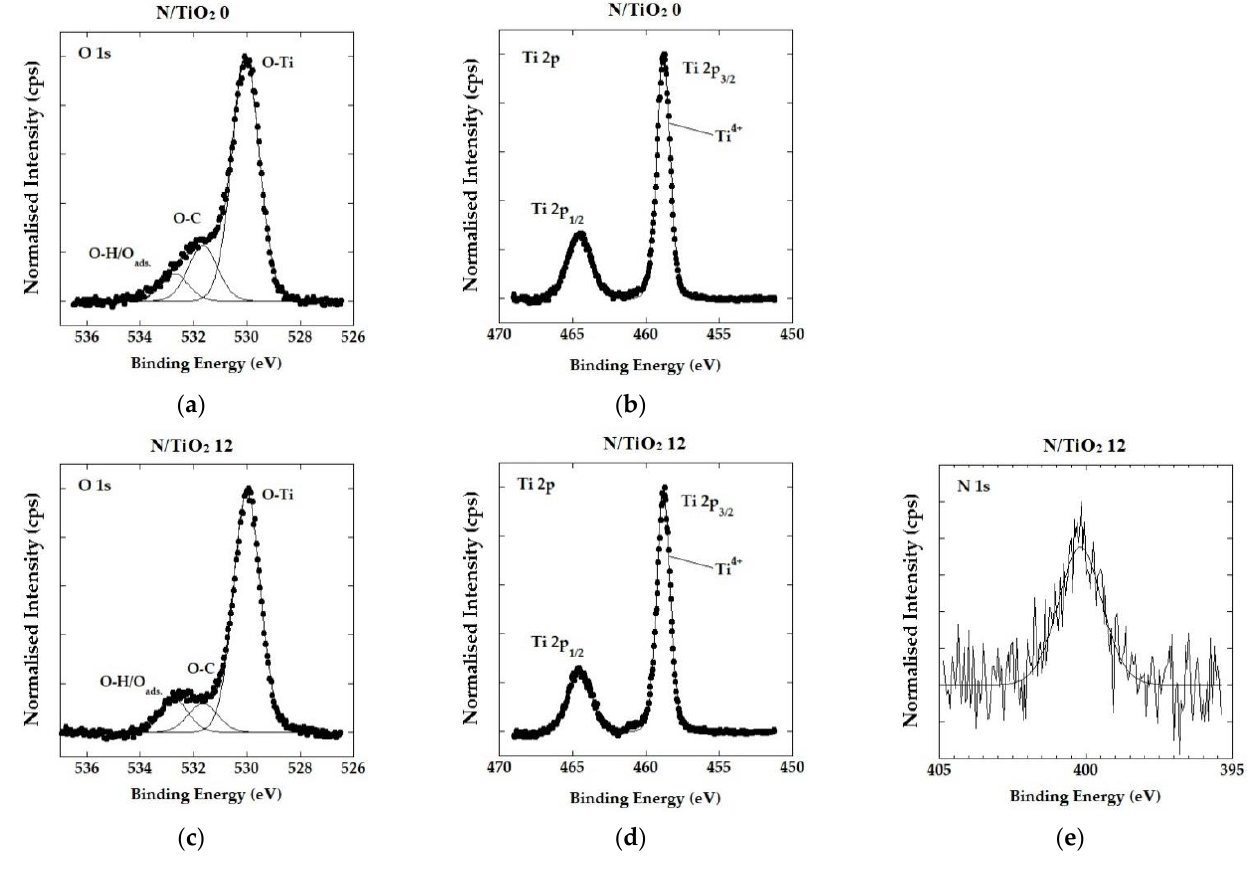
Figure 6. High-resolution XPS spectra: ( a ) O 1s spectrum, and; ( b ) Ti 2p spectrum, N/TiO 2 0; ( c ) O 1s spectrum; ( d ) Ti 2p spectrum, and; ( e ) N 1s spectrum N/TiO 2 12.